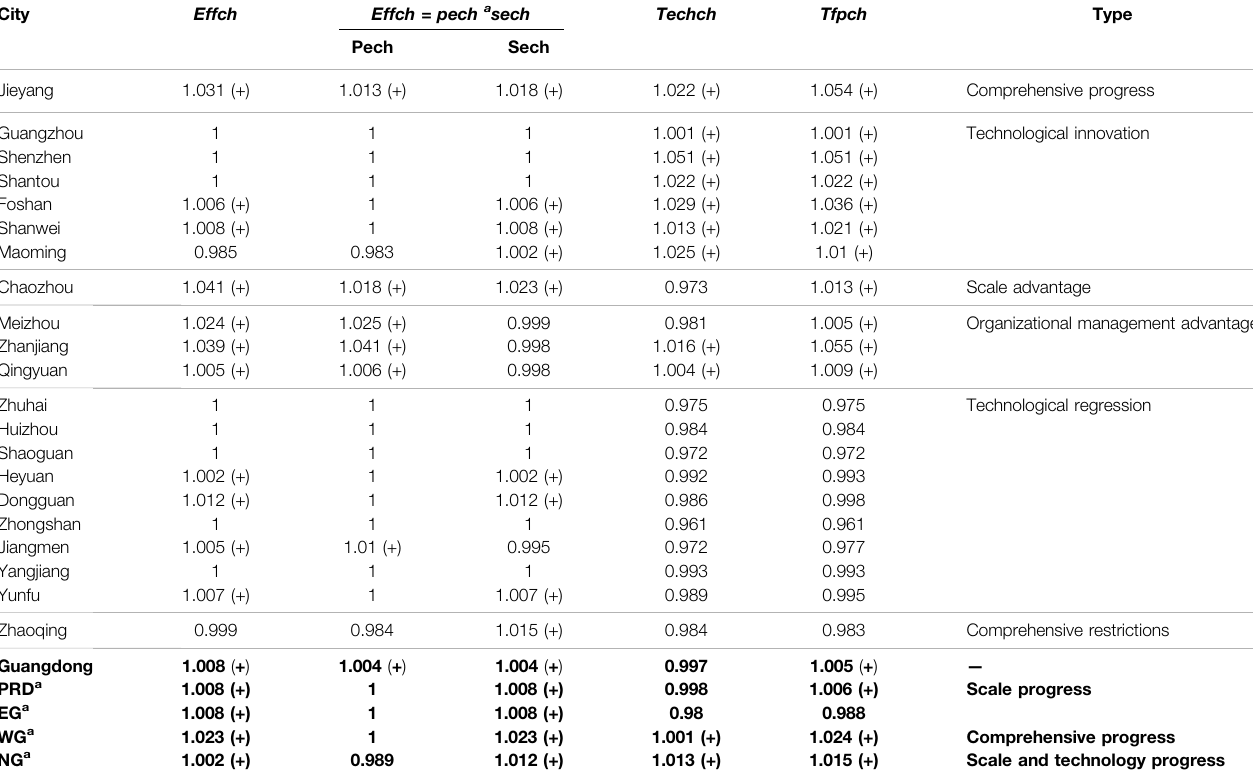
TABLE 5 | Malmquist index and its decomposition of average water resources in prefecture-level cities and regions in the last 9 years. City